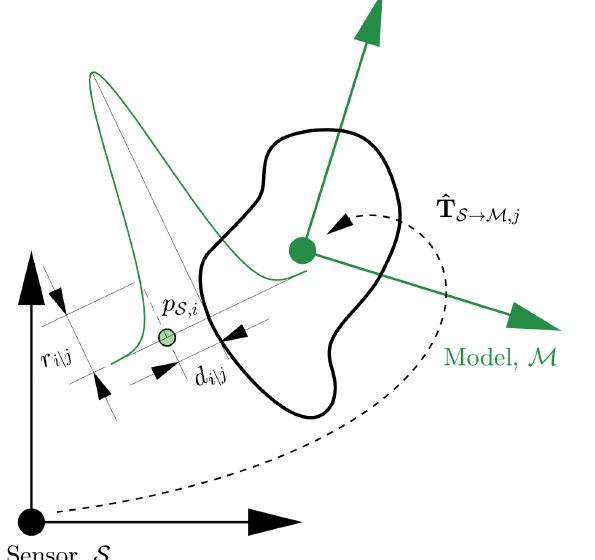
Figure 4. Consider a geometry model that has been located relative to the sensor with the j -th pose hypothesis, ˆT S→M , j . The i -th point in the sensor frame, p S , i , has a distance of d i ∣ j to the model’s surface. This would result in a reward of r i ∣ j when evaluated with the Gaussian reward function. The total reward is calculated as the summation of all n points in the point cloud.